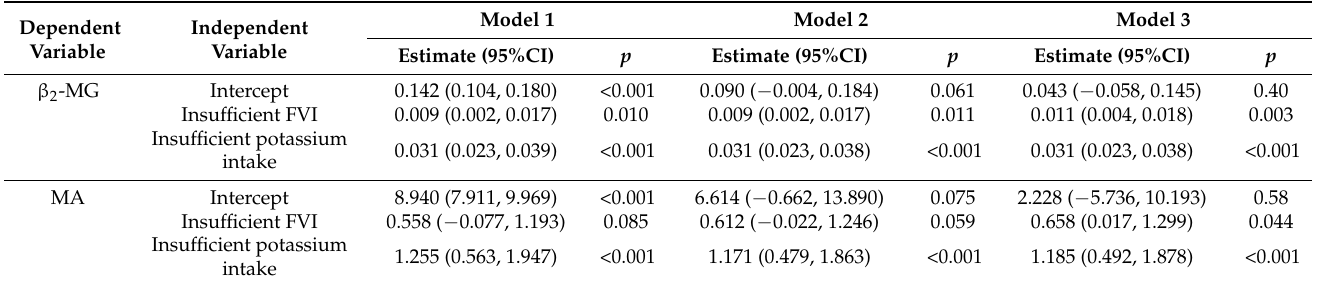
Table 3. Multivariable associations of renal damage indicators with insufficient FVI and insufficient potassium intake using linear mixed effects models among 6–9 year old children, Beijing,